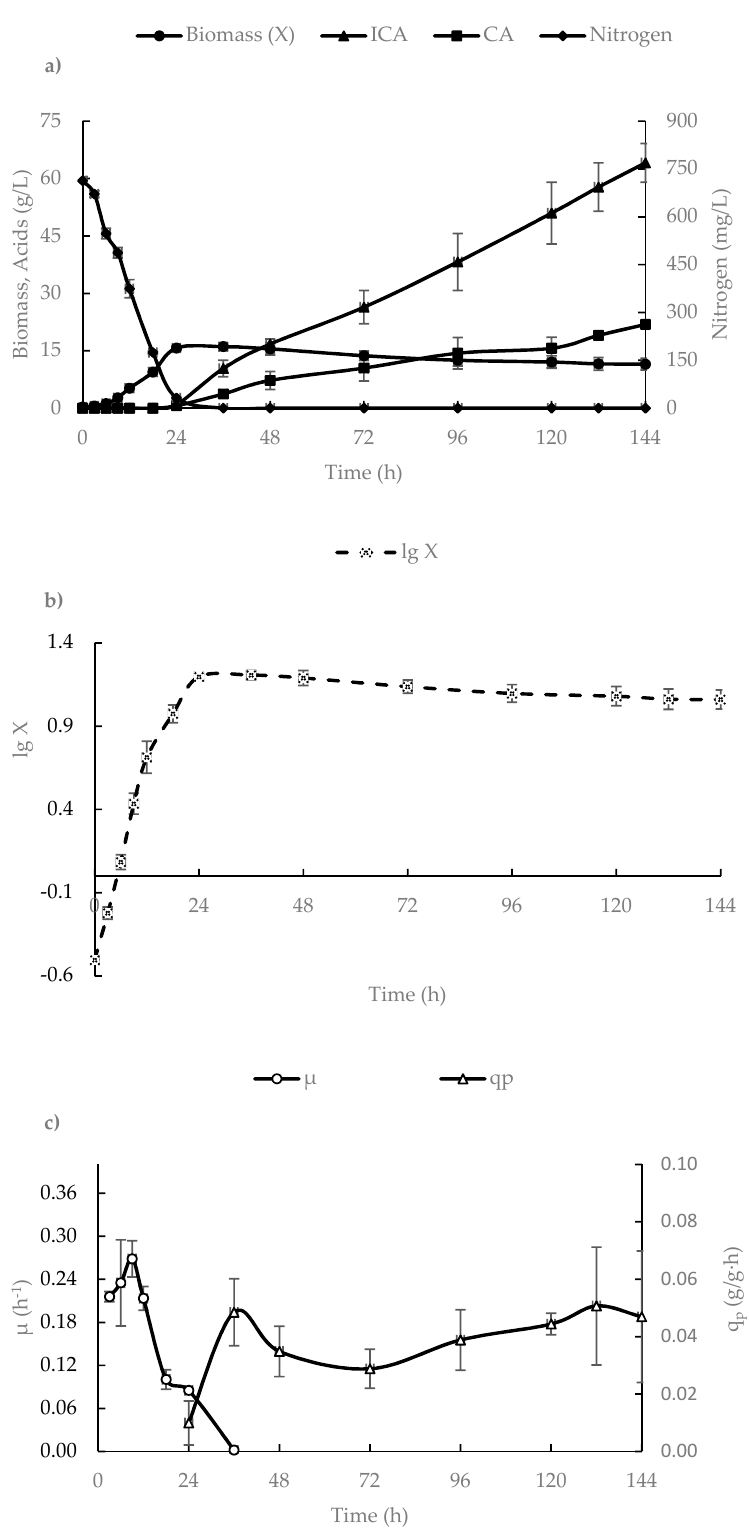
Figure 1. The dynamics of the nitrogen consumption in the medium, biomass (X) accumulation, isocitric acid (ICA), and citric acid (CA) production in Y. lipolytica VKM Y-2373 cultivated in a 500-L bioreactor ( a ), the lg X curve ( b ), and the calculated parameters of the specific growth rate ( µ ) and the specific rate of ICA synthesis (q p ) ( c